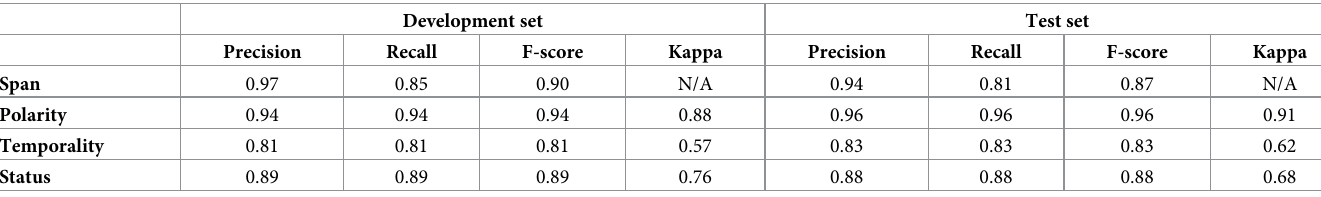
Table 3. Micro-averaged mention-level evaluation